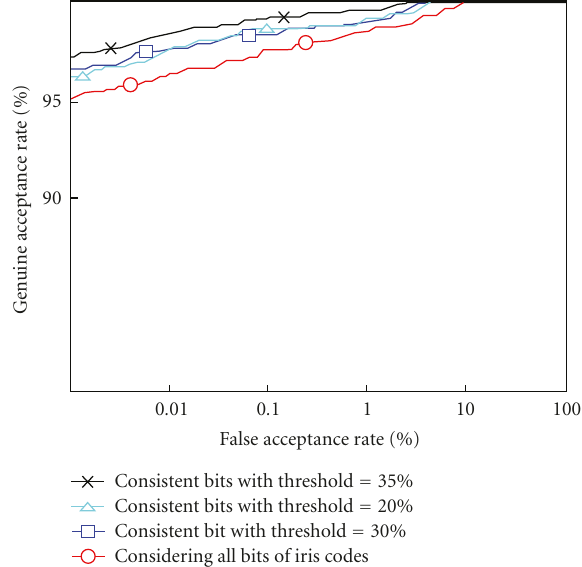
Figure 5: Comparison of ROC curves of our proposed method using all bits of iris code and using only the consistent bits with di ff erent thresholds. As it can be seen, the performance of system considering consistent bits with threshold equal to 35% is the best. (Tests using CASIA-IrisV3 dataset).